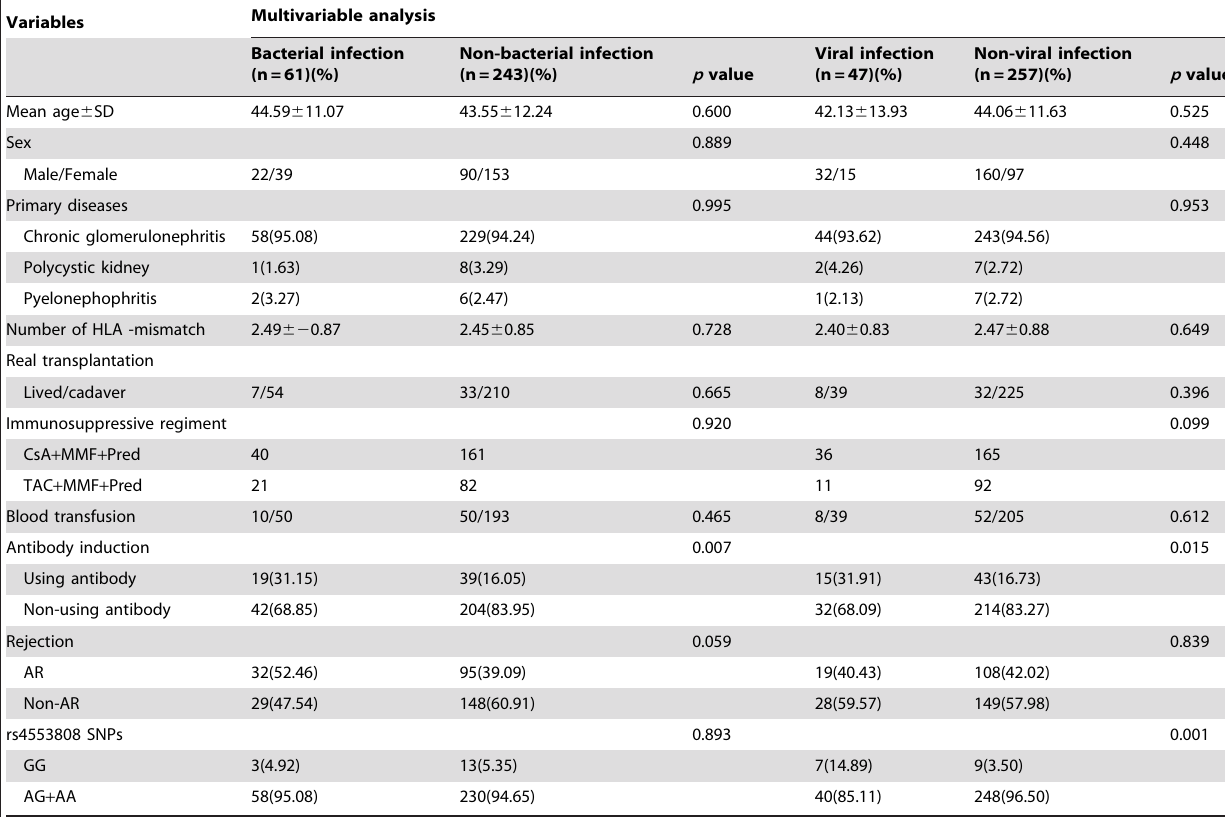
Table 6. Association between bacterial or viral infection and several risk factors.